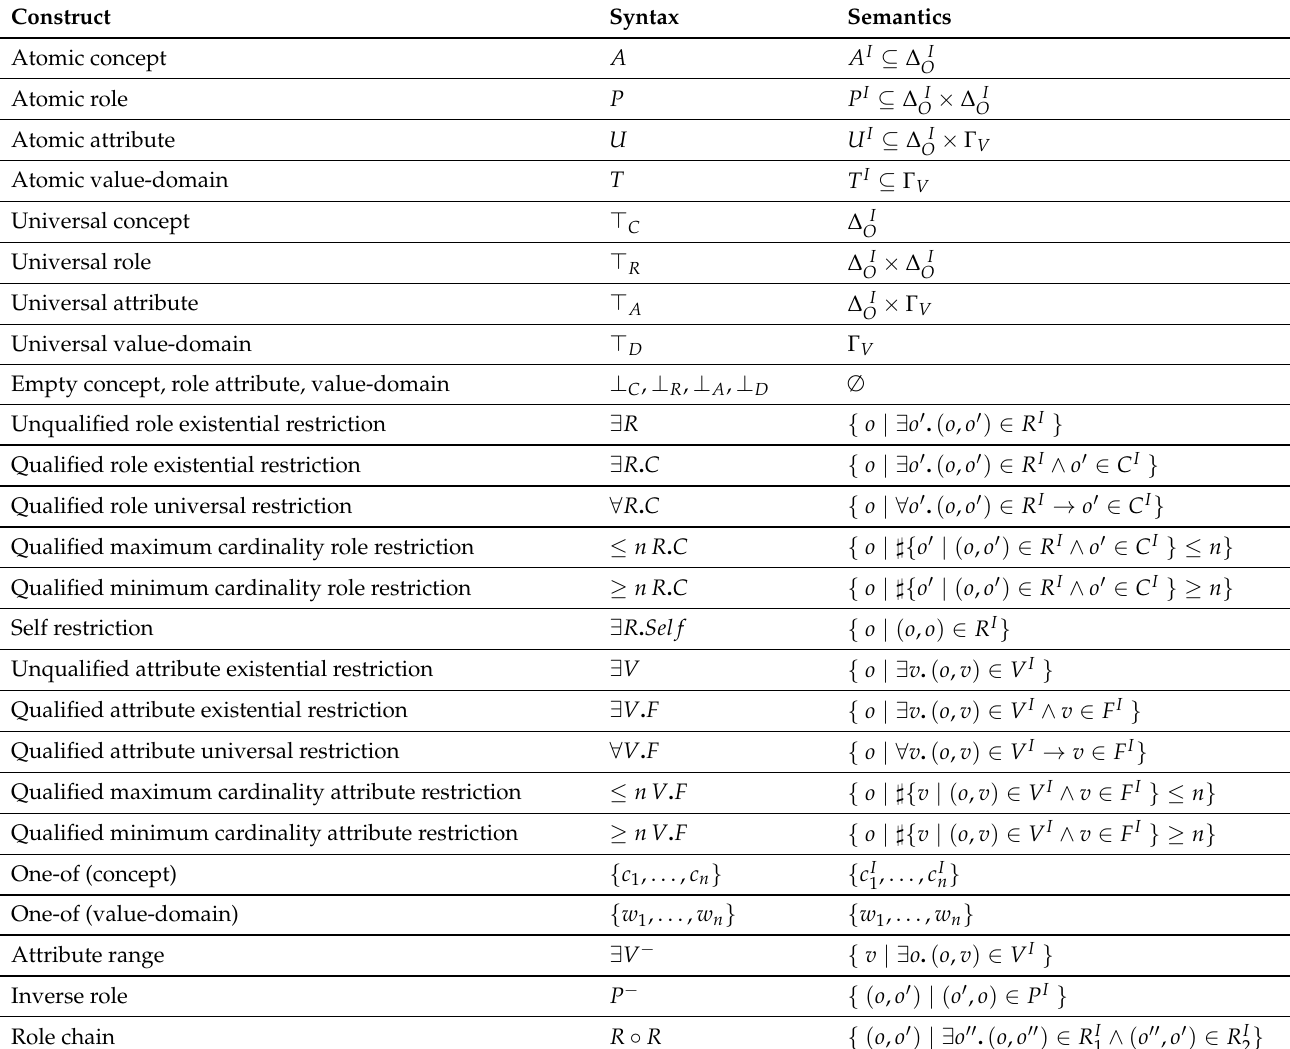
Table 1. The DL constructs with their